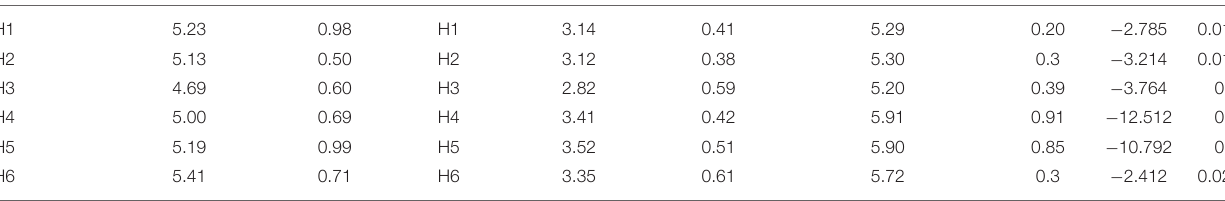
TABLE 9 | Assessing the